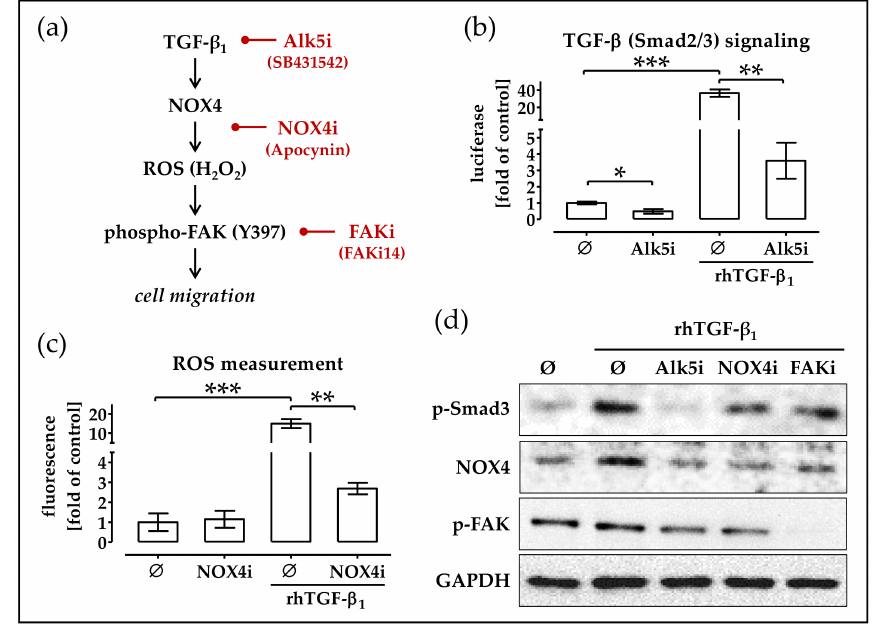
Figure 5. rhTGF- β 1 -induced NOX4 expression activates focal adhesion kinase signaling. ( a ) Simplified overview on the proposed mechanism. ( b ) phOBs ( N = 4, n = 3), infected with the Smad3/4